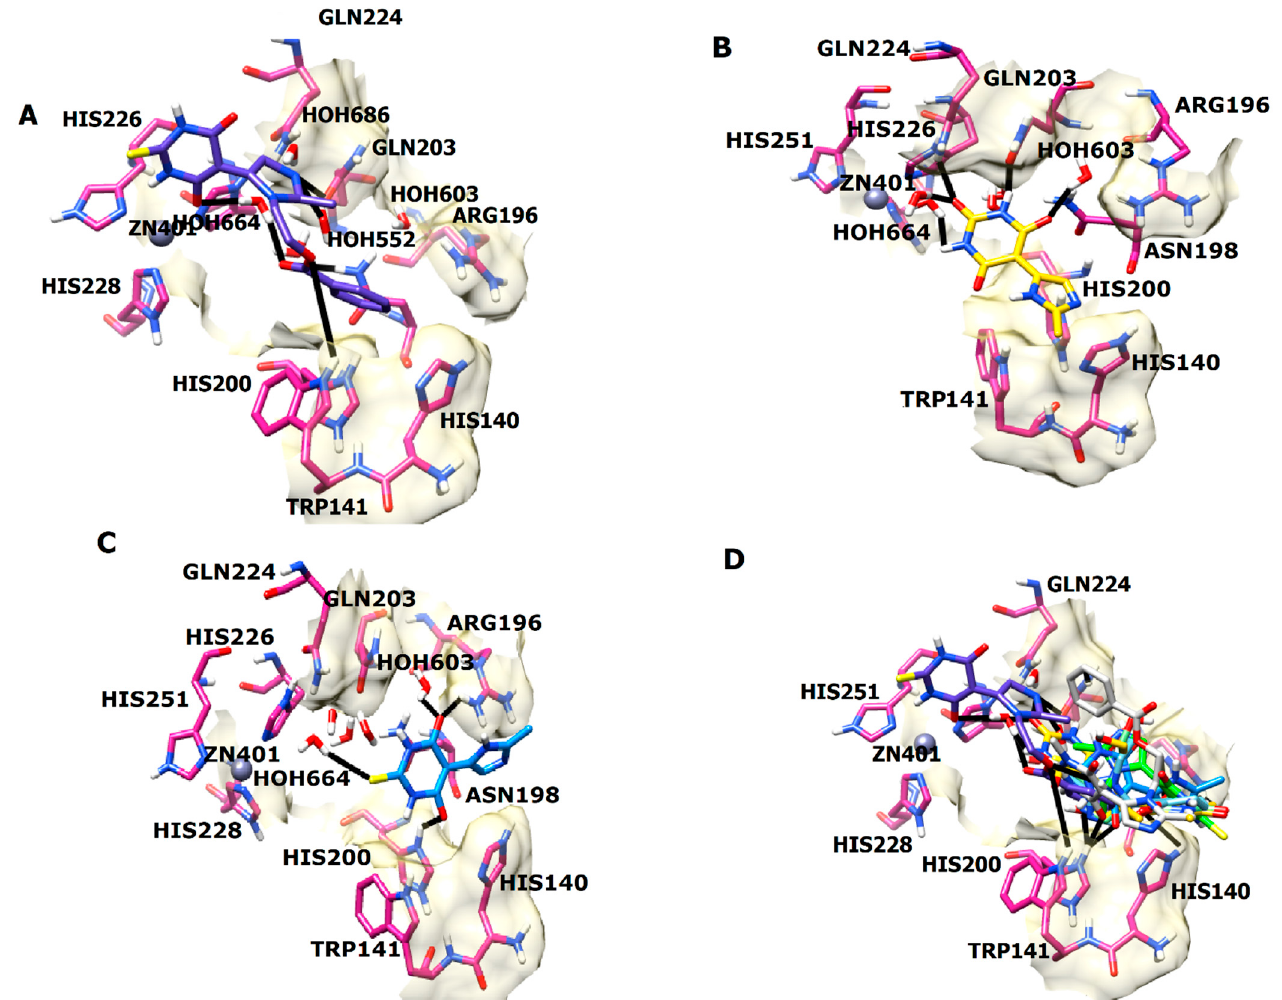
Figure 5. The binding orientation of active compounds is shown in the active site of hCA-IX. ( A–C ) The docked pose of the most active compounds, 7 , 3 , and 4 . ( D ) The binding modes of all the inhibitors at the active site of hCA-IX. In the active site, zinc is presented as a slate blue sphere, the ligands are depicted in different colors in stick models, the active site residues are shown in pink stick models, and the hydrogen bonds are presented in black lines.